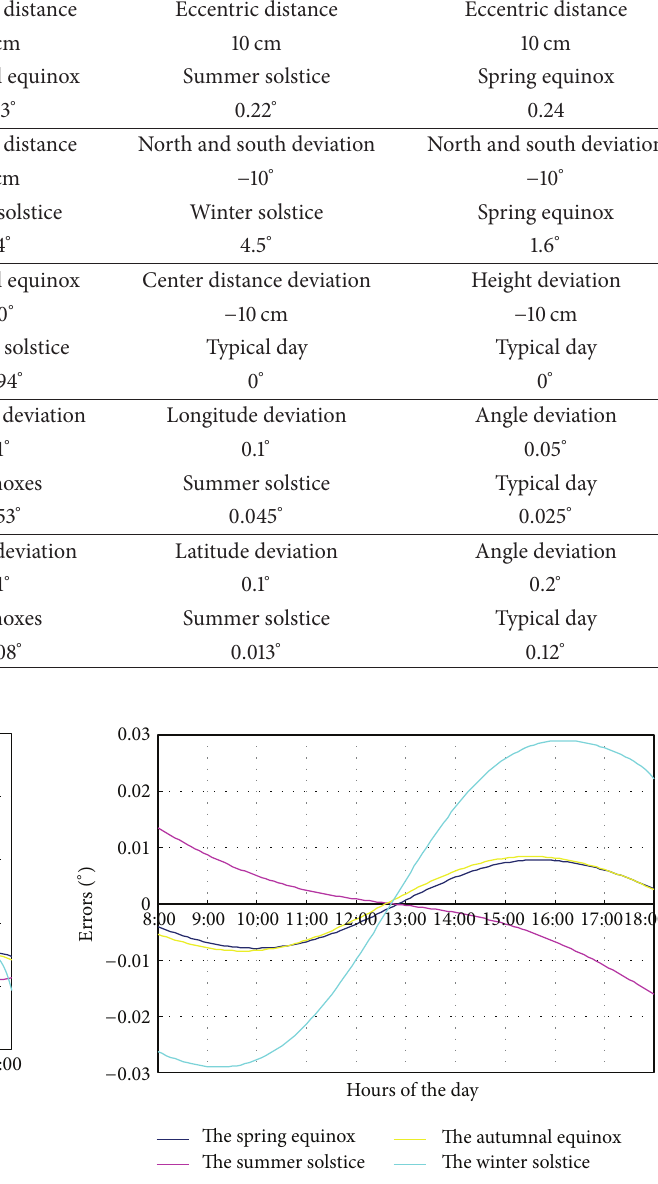
Figure 8: The tracking error of longitude 0.1 ∘ deviation.